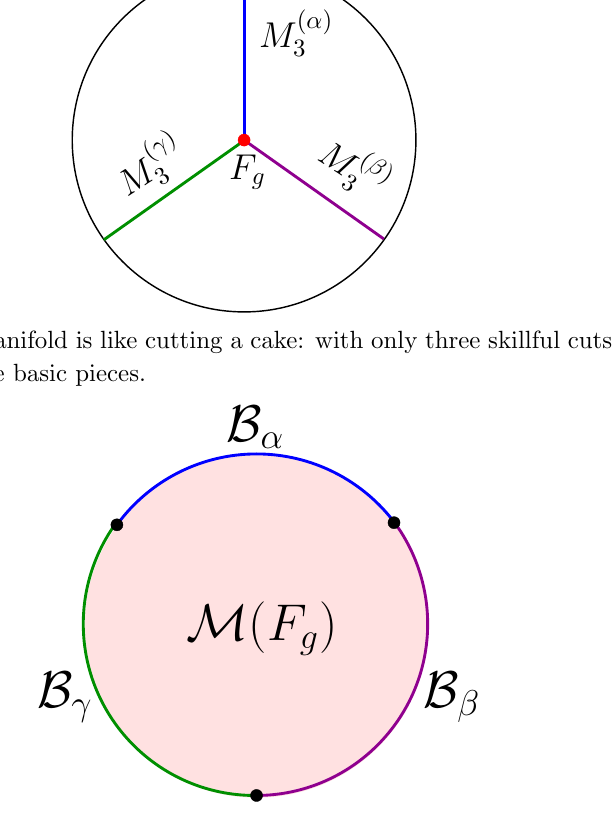
Figure 2 . Disk amplitude in the A-model of M ( F g ), with three Heegaard boundary conditions, dual to the trisection in (cid:12)gure